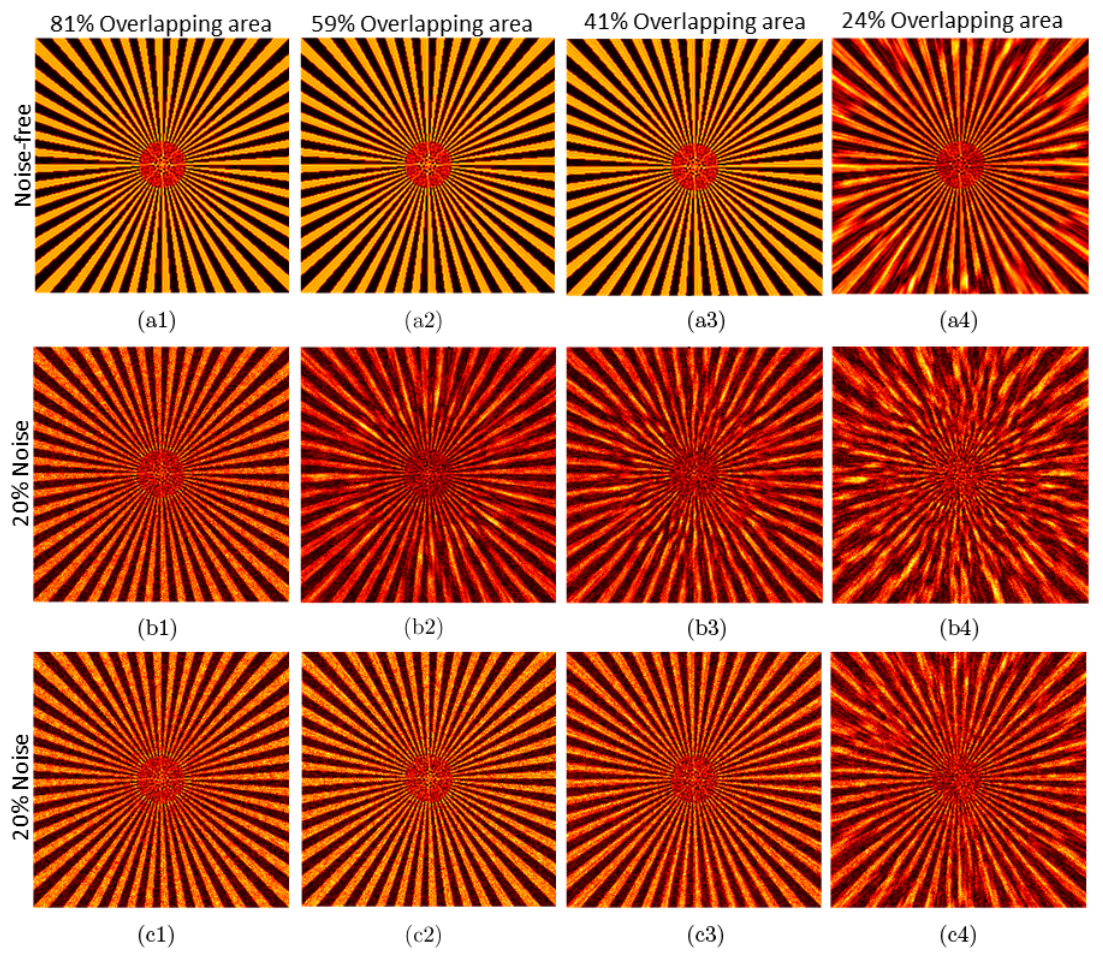
Fig. 7. Noise performance of FPM with 20% additive Gaussian noise level. (a1) – (a4) Images of noise-free, spoke-like sample iterated until convergence with 81%, 59%, 41% and 24% overlapping area in frequency domain, respectively. (b) – (c) Corresponding images of the same sample with 20% additive Gaussian noise level. (b1) – (b4) Iterating for only once, and (c1) – (c4) iterating until